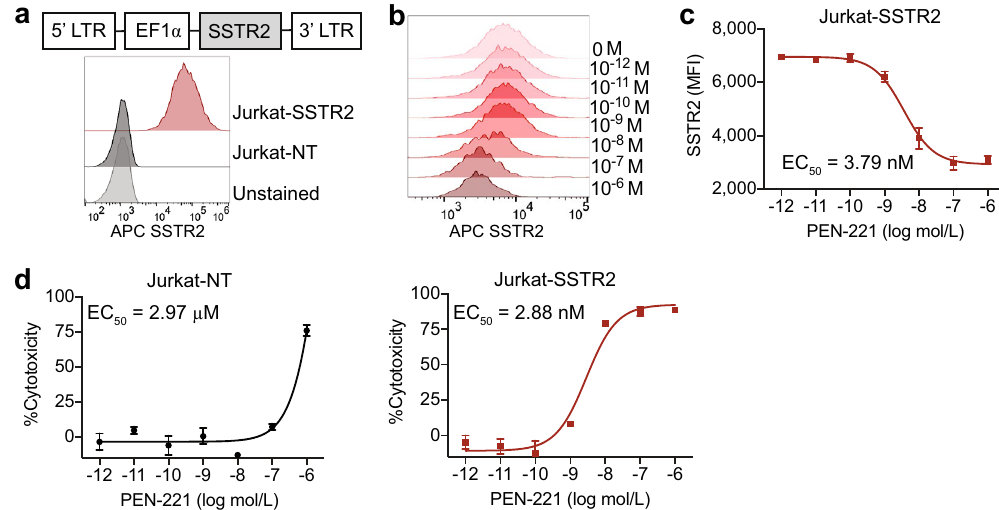
Figure 1. PEN-221 induces internalization of SSTR2 and exhibits specific cytotoxicity against SSTR2- expressing Jurkat cells in vitro. ( a ) Schematic representation of the lentiviral vector encoding human SSTR2 (SSTR2). Histograms show the expression of SSTR2 in non-transduced (NT) Jurkat and Jurkat-SSTR2 cells determined by flow cytometry. ( b ) Representative flow-cytometric measurements of SSTR2 internalization in Jurkat-SSTR2 cells after treatment with 10-folds serially diluted PEN-221 (10 –6 to 10 –12 M). ( c ) EC 50 curve of SSTR2 internalization. The mean fluorescence intensity of surface SSTR2 is indicative of the internalization of the receptor. ( d ) Cytotoxicity of PEN-221 against SSTR2-expressing Jurkat T cells, using Jurkat-NT cells as control. Data were presented as the mean ± SD of triplicate